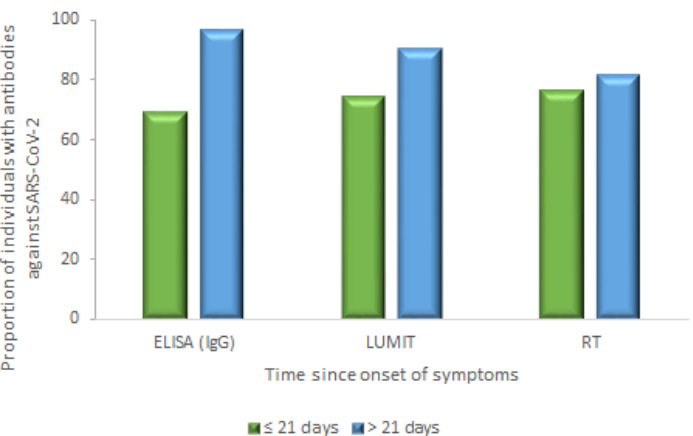
Figure 3. Proportion of RT-PCR positive individuals with antibodies against SARS-CoV-2 detected by ELISA (IgG), LUMIT, and RT according to two symptoms onset categories. The diagnostic performance of three immunoassays for detecting antibodies against SARS-CoV-2 was evaluated according to time from symptoms onset. RT (Wondfo) and LUMIT (Promega) were compared to ELISA (Euroimmun), which is considered the gold standard for serological tests.